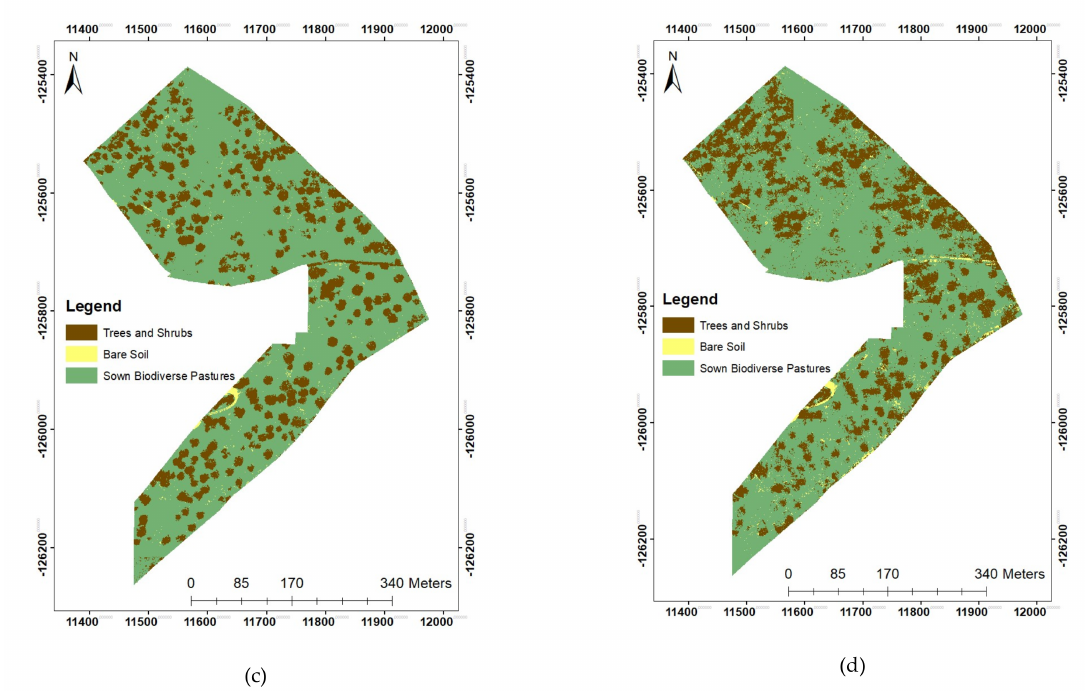
Figure A4. Land cover maps produced through multitemporal classification using Support Vector Machines for farms 2 ( a ) and 3 ( c ) and Artificial Neural Networks for farms 2 ( b ) and 3 ( d